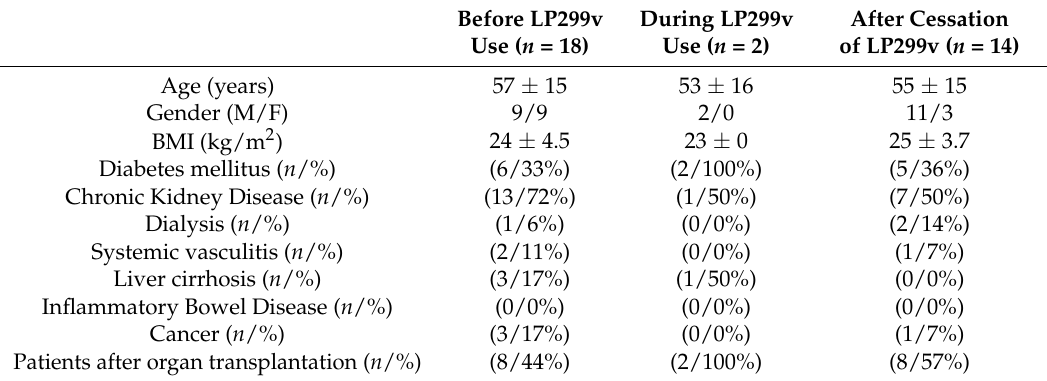
Table 4. Clinical characteristics of patients with Clostridium difficile infection (CDI) in periods before, during and after cessation of LP299v administration ( n = 34). The above-mentioned periods lasted twelve